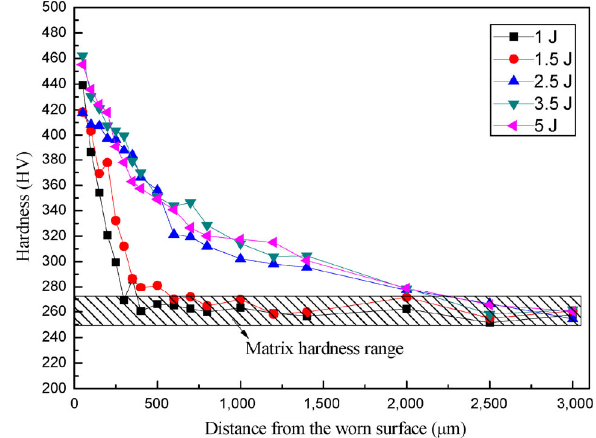
Fig. 4 The hardness of the worn surface. Fig. 5 The hardness of the subsurface.